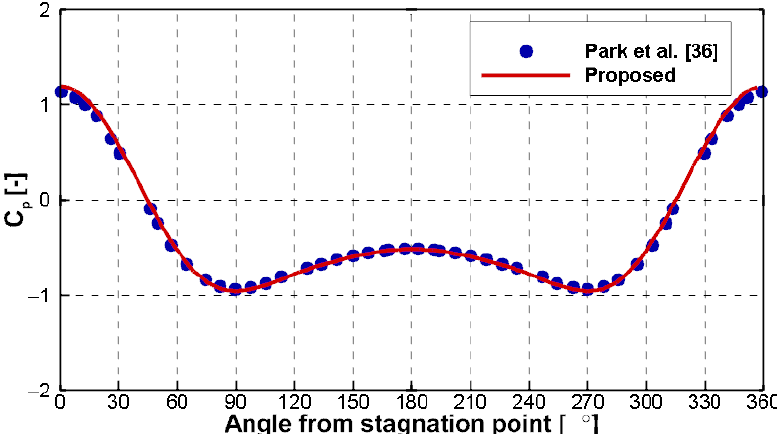
Figure 9. ( a ) Velocity vector fields and ( b ) streamlines around a circular cylinder ( Re = 100, t = 400 s).